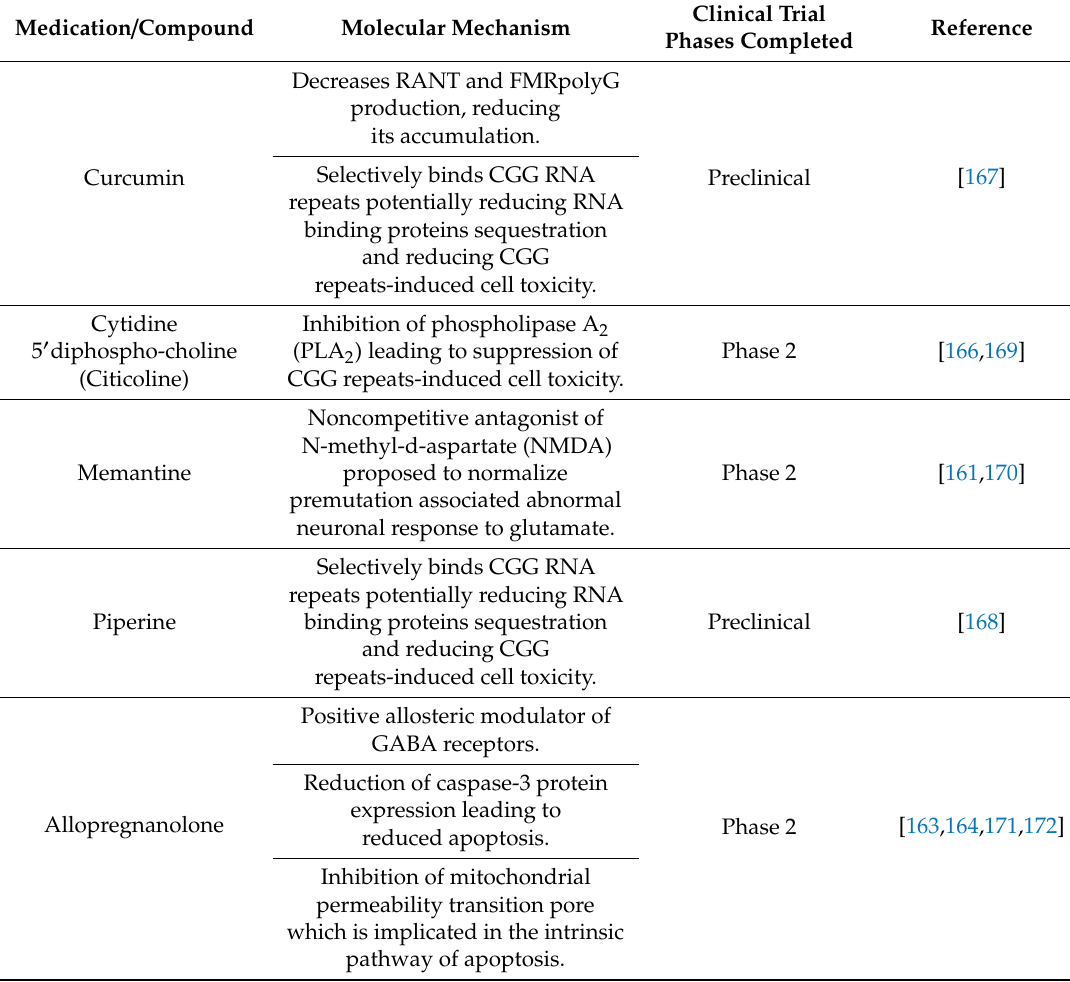
Table 2. New therapeutic approaches and associated molecular